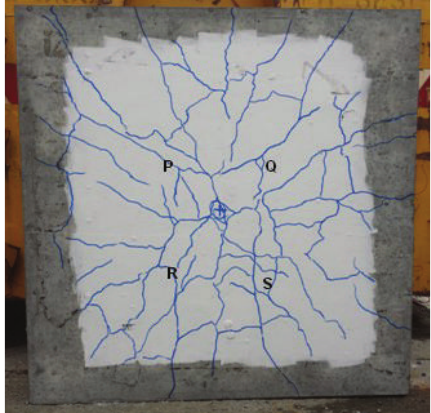
Figure 32: Transducer displacements ( 𝑥 -direction).